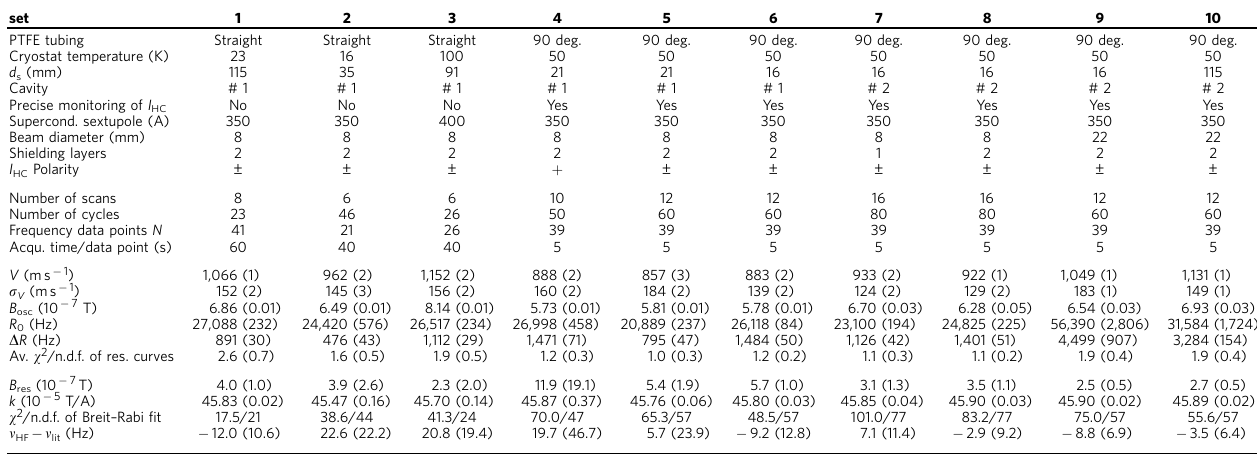
Table 1 | Parameters of the data sets. set